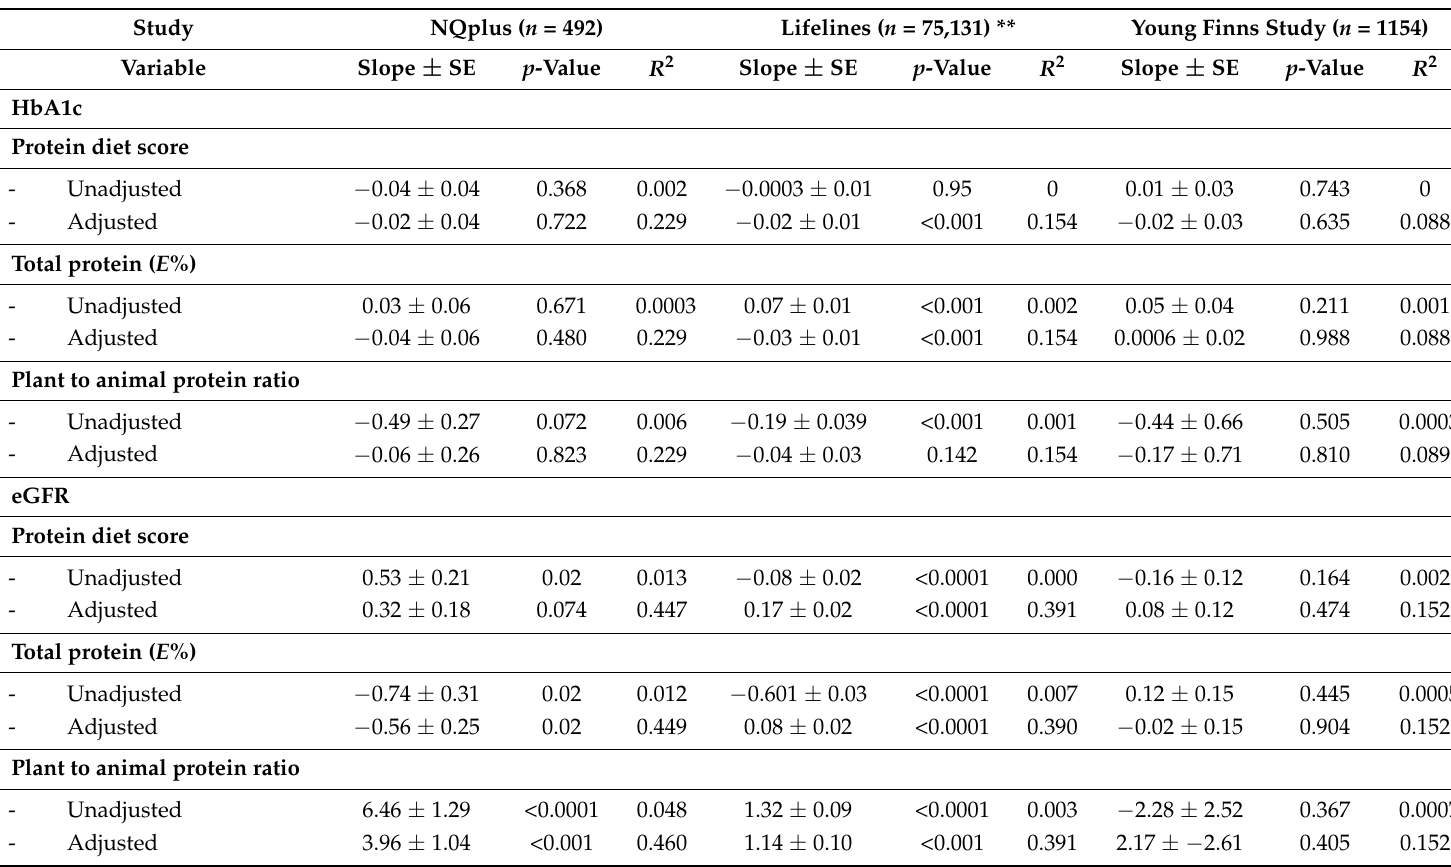
Table 2. Associations of glycated haemoglobin (HbA1c) and estimated glomerular filtration rate (eGFR) (estimate ± SE) across quintiles energy-adjusted protein diet score and quintiles of its energy-adjusted